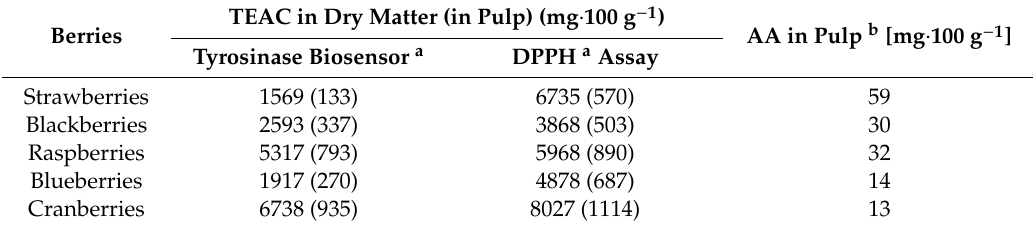
Table 1. TEAC and AA content in various